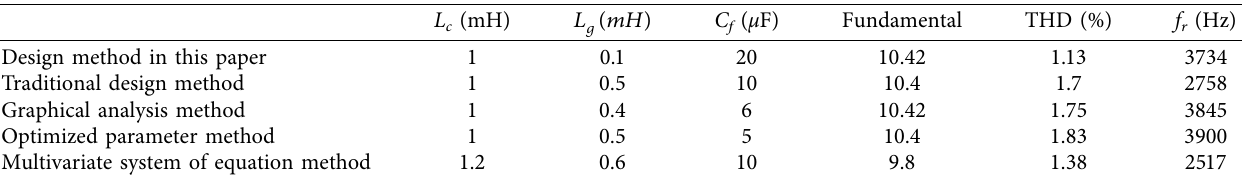
Table 4: Te LCL flter parameter designed by diferent methods and the corresponding parameter HCSY-MG system grid-connected